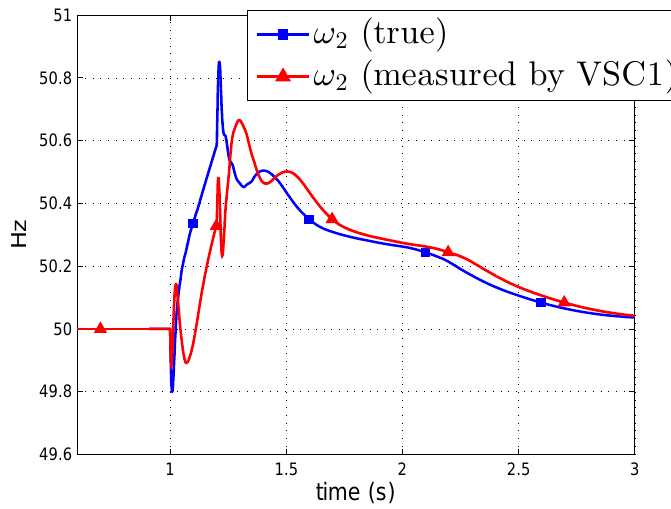
Figure 12. Strategy P-WAF with τ ij = 100 ms. Frequency of VSC2 measured by